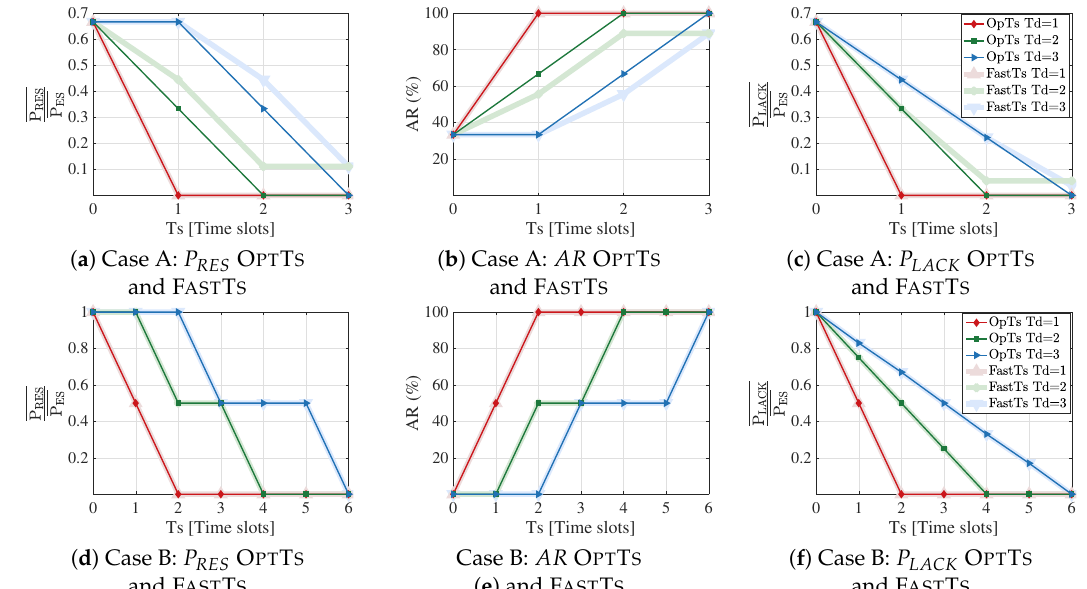
Figure 14. Performance evaluation of the O PT T S and F AST T S for Case A and Case B. Parameters: Based on Table 5.